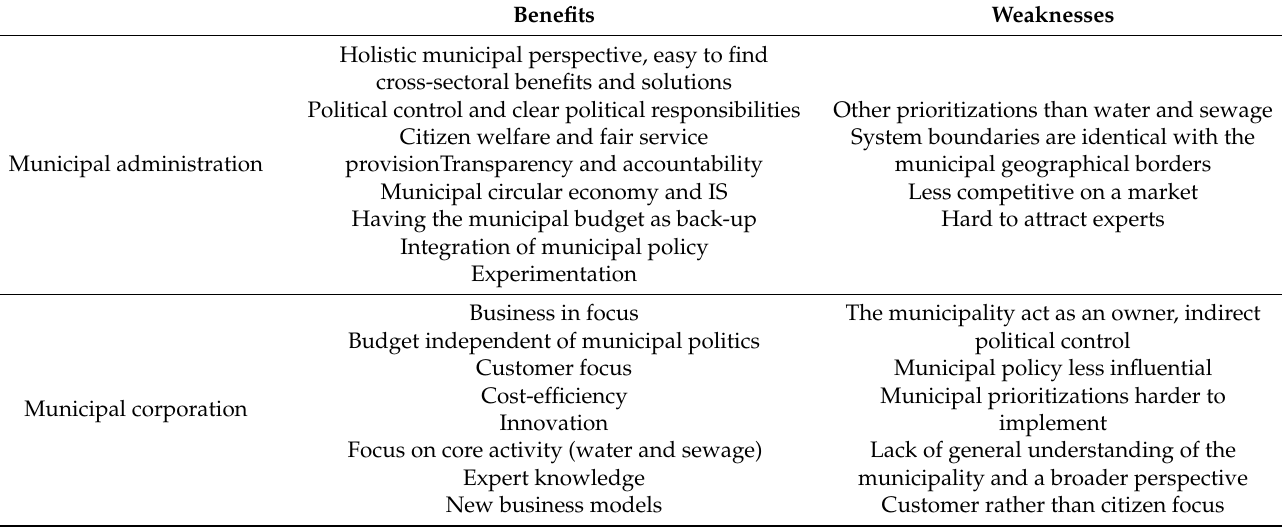
Table 3. Summary of benefits and weaknesses with different organization forms identified in